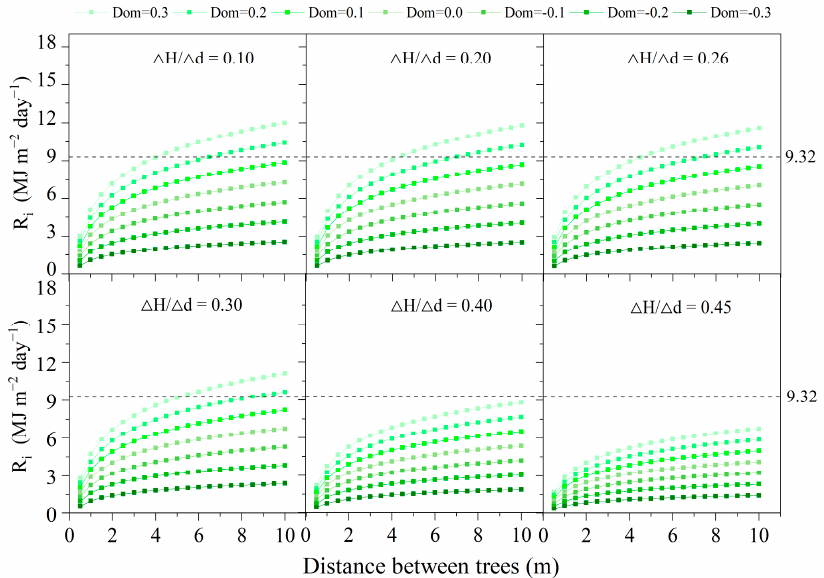
Figure 10. Variation in the simulated R i with R h at different Dom and slope position levels by the R i model (Equation (10)). The value of R h of 9.32 MJ m − 2 day − 1 used the long-term mean values from 2013 to 2021. Δ H / Δ d represents the ratio of the height difference to the horizontal distance between the sample point and the top of the opposite mountain. Δ H / Δ d = 0.26 was the threshold indicating that the sample point had no shaded terrain effect (Figure 4c).